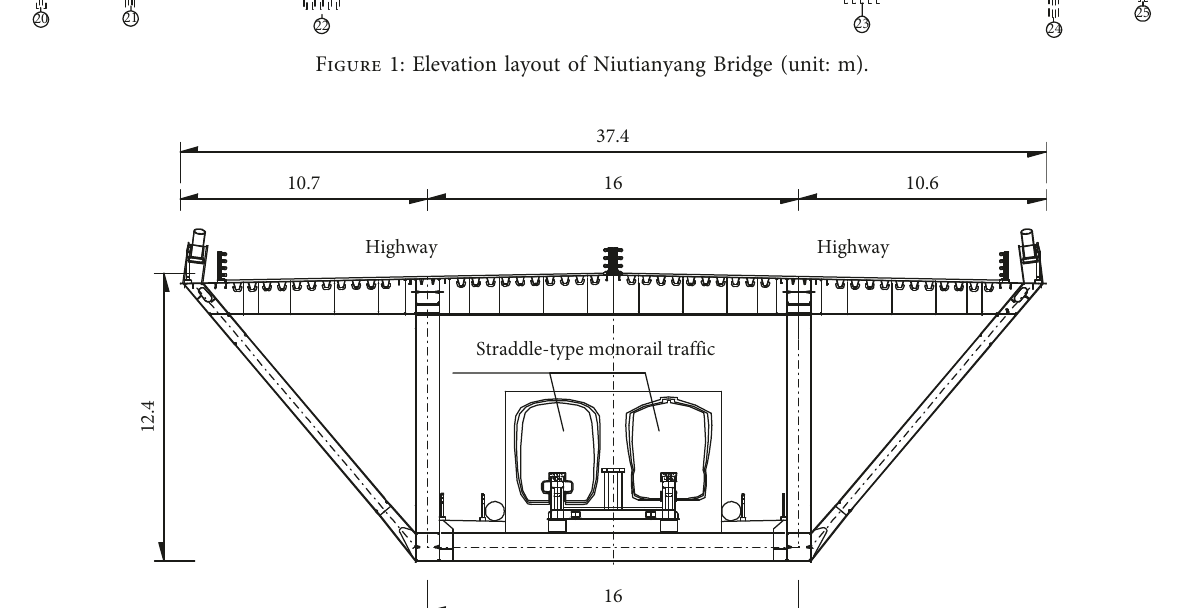
Figure 2: Standard cross section of steel truss girder (unit: